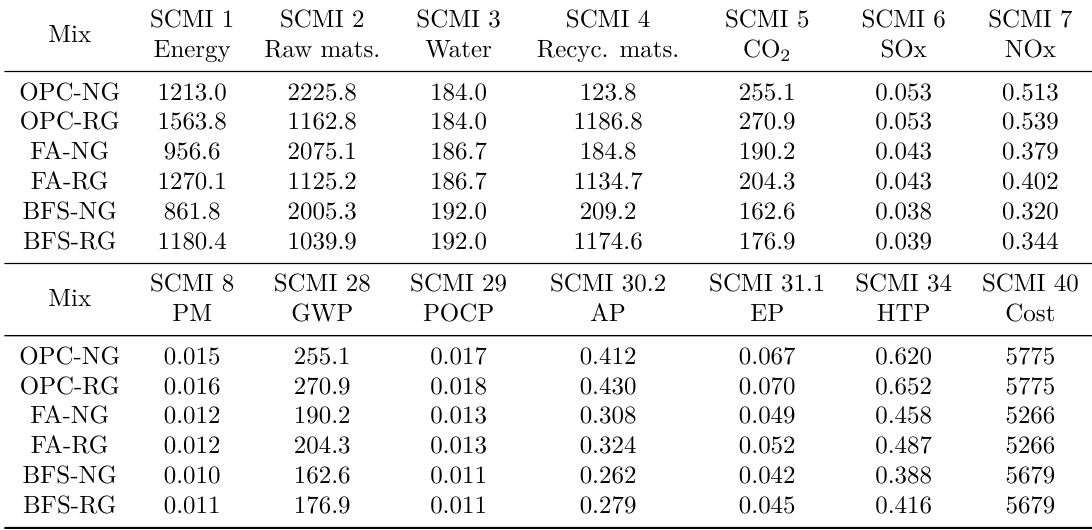
Table 3. Mix proportions and 28-day compressive strengths of the concrete